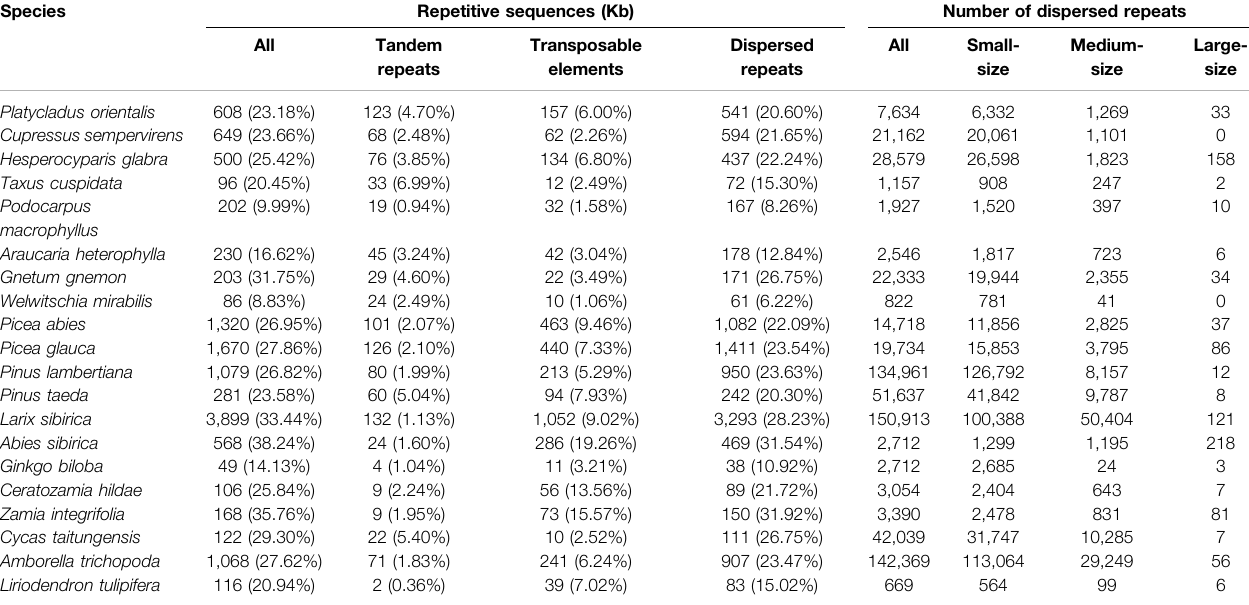
TABLE 5 | Repetitive sequences in each mitogenome. Dispersed repeats are divided into small-size ( < 100 bp), medium-size (100 – 1,000 bp), and large-size ( ≥ 1,000 bp) classes. Note, overlapping repetitive sequences are counted only once when calculating their total size.